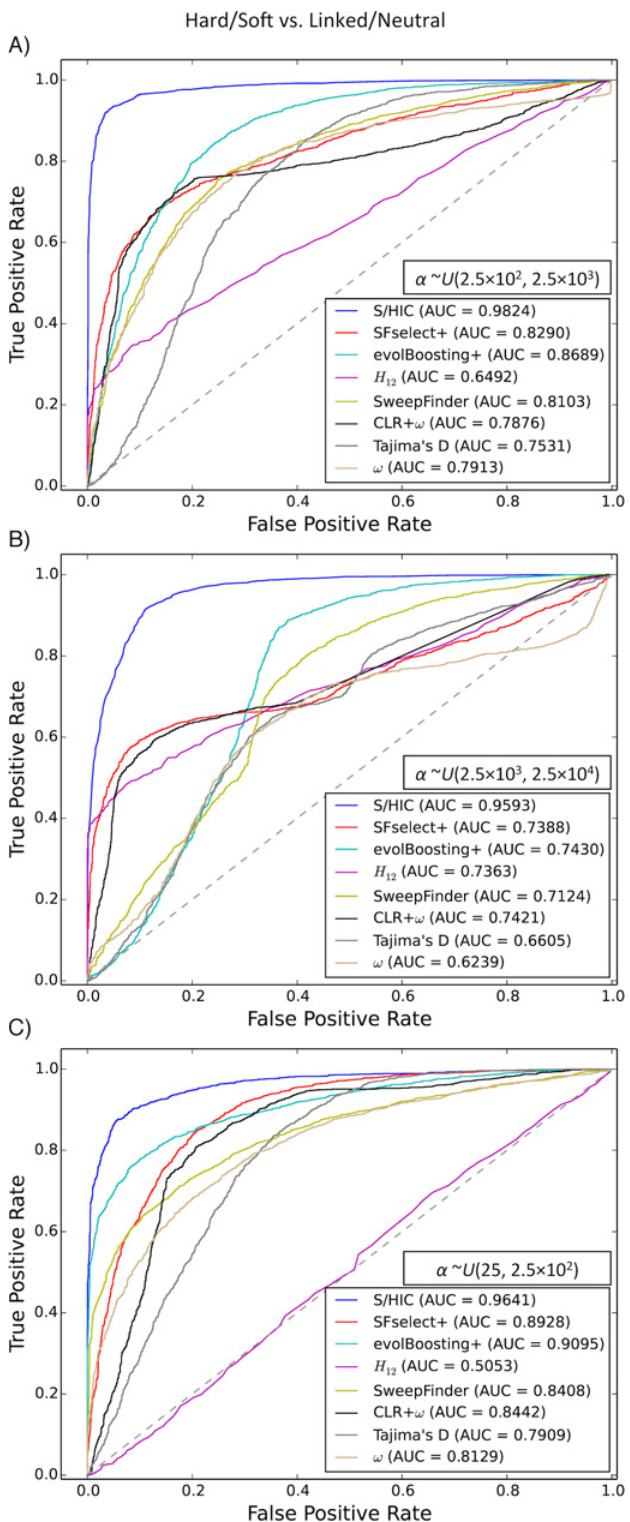
Fig 3. ROC curves showing the true and false positive rates of various methods/statistics when tasked with discriminating between regions containing a sweep (either hard or soft) and